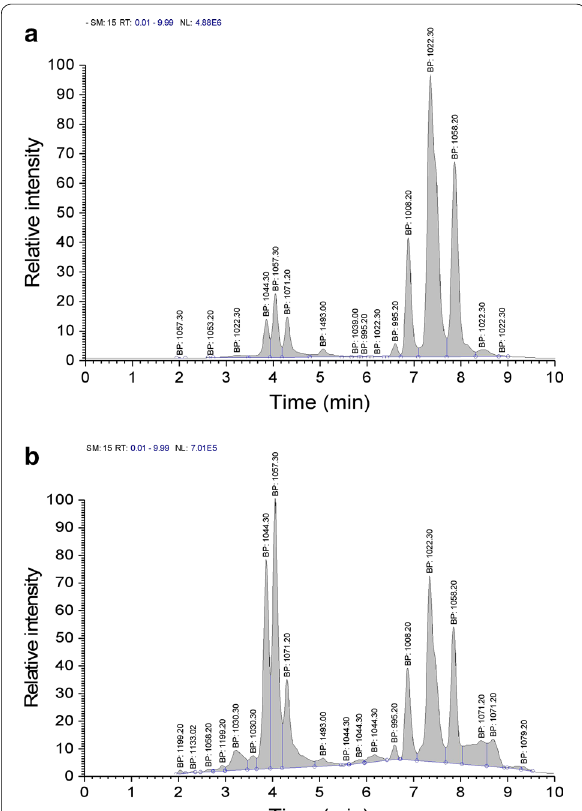
Fig. 4 Ion chromatogram of iturin and surfactin homologues produced by Landy medium with added 0.6% activated carbon powder ( a ) and 0.4% attapulgite powder ( b